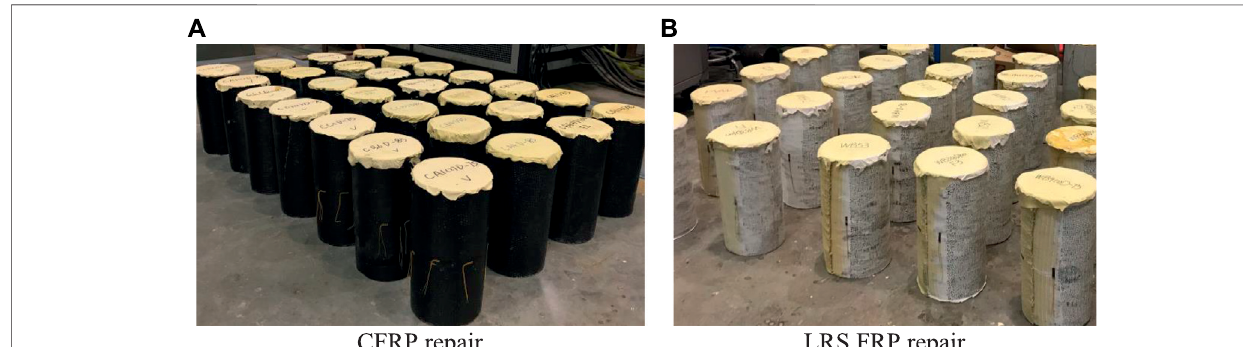
Figure 7 | Repaired specimens with CFRP and LRS FRP.